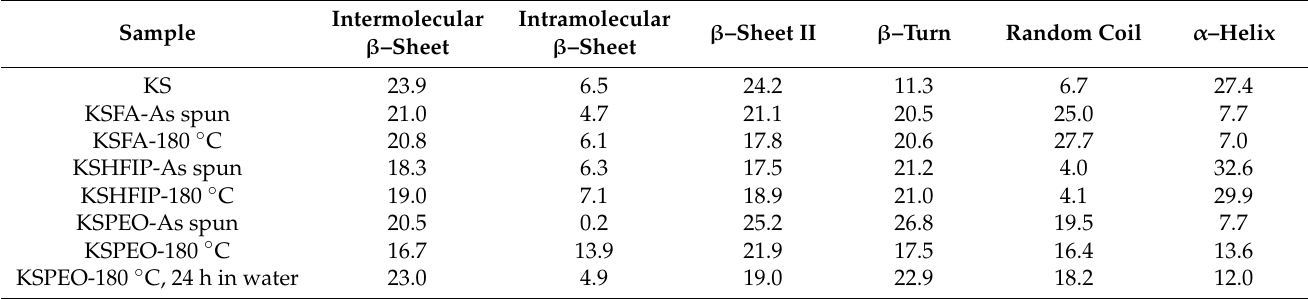
Table 2. Protein secondary structure content